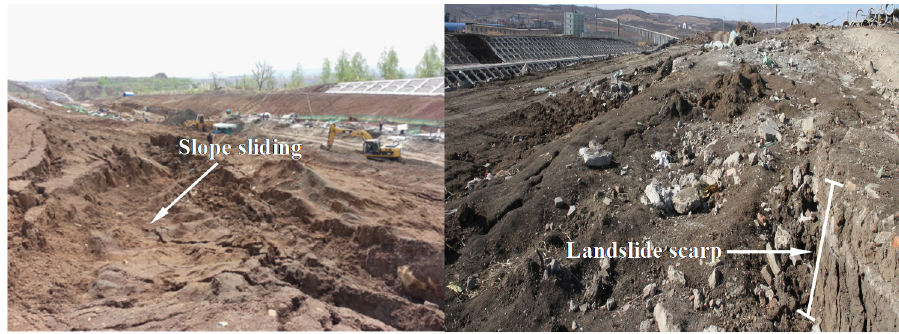
Figure 1. The cutting slope failures along the high-speed railway (the left figure is from